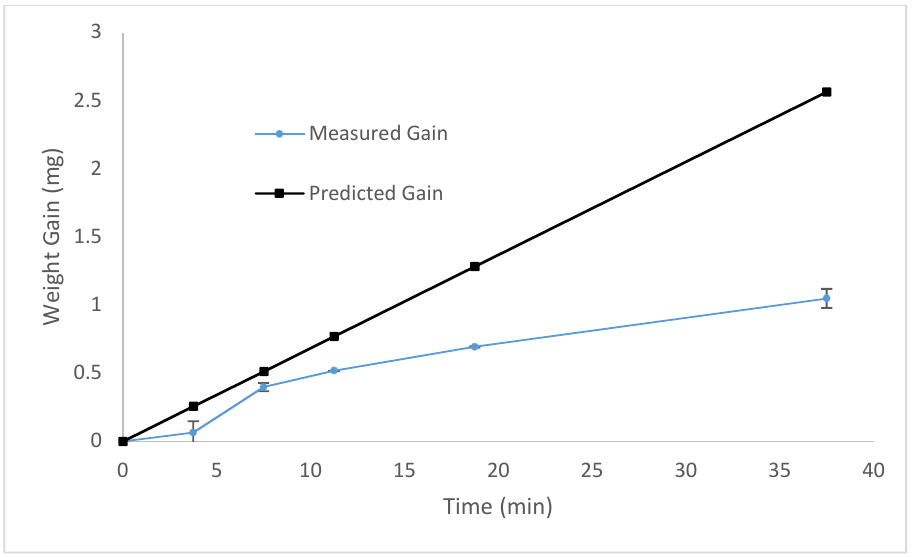
Figure 5. Mass of collagen deposited with increasing plasma exposure.